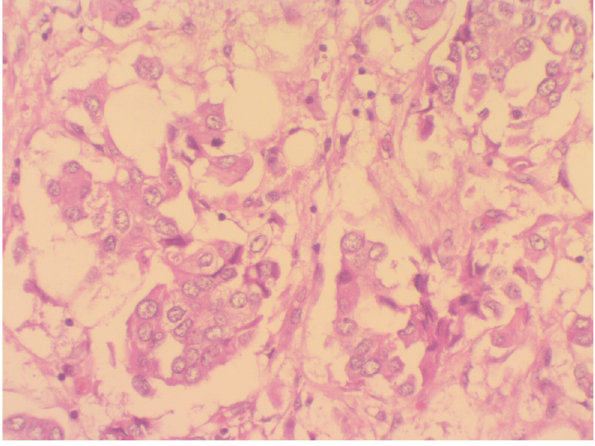
Figure 2. Prostatic adenocarcinoma. (H&E stain, X400 magnification).